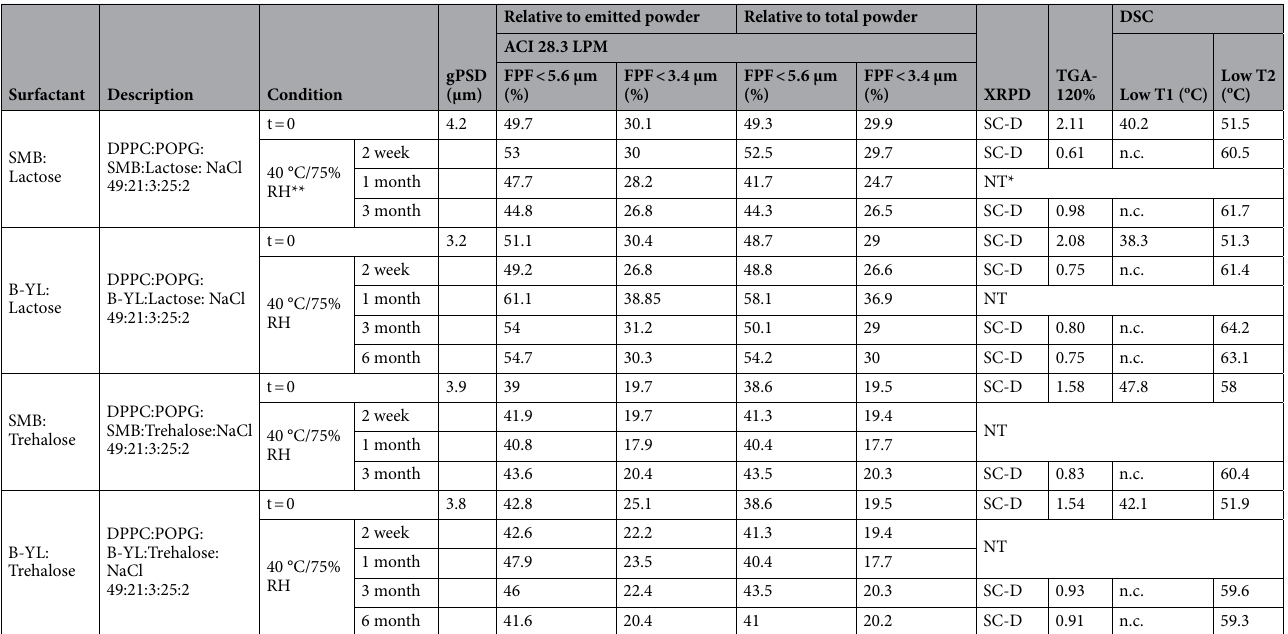
Table 3. Aerosol properties and solid state properties of each of the second series of dry powder surfactant formulations tested. Powders have the same phospholipid composition, but differ in regard with SP-B peptide mimic (SMB or B-YL) and excipient (Lactose or Trehalose). Samples have desiccant incorporated in the packaging. *NT: Not Tested; **RH: Relative Humidity; n.c.: not